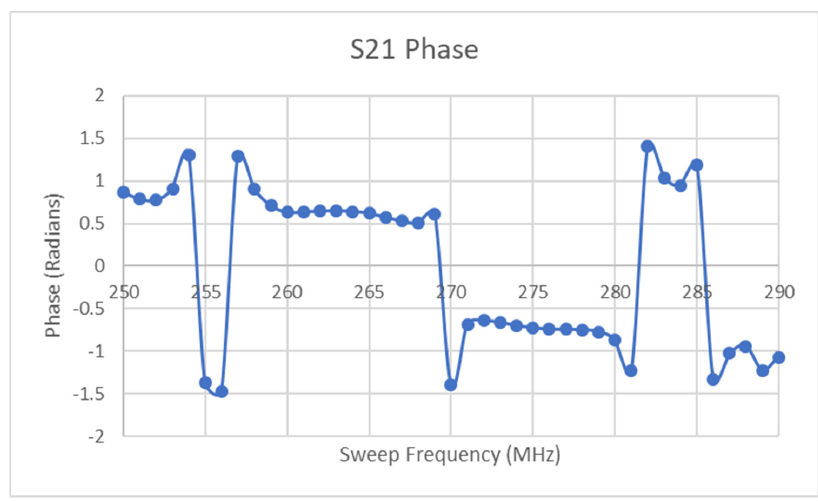
Figure 18. Phase response of S21 data.